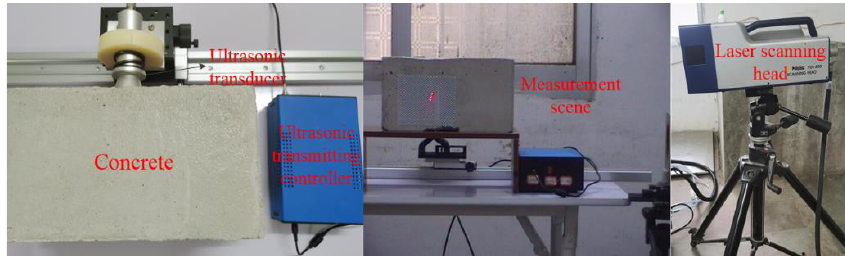
Figure 3. Laboratory equipment.